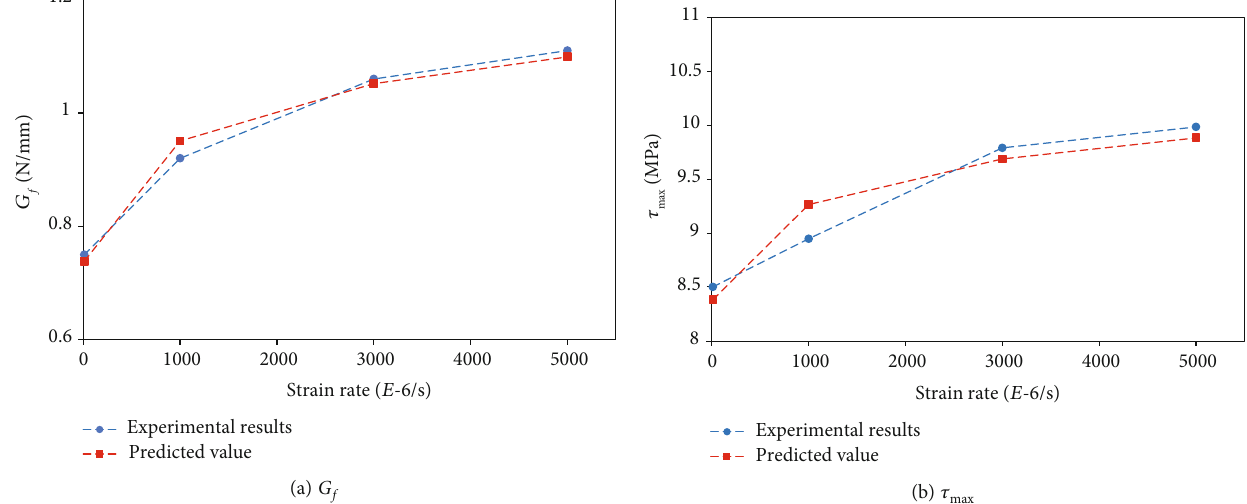
τ f and max between experimental and estimated values.